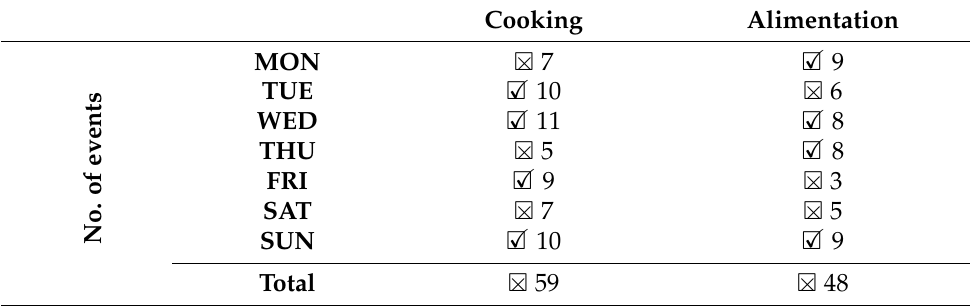
Table 20. Results of the second